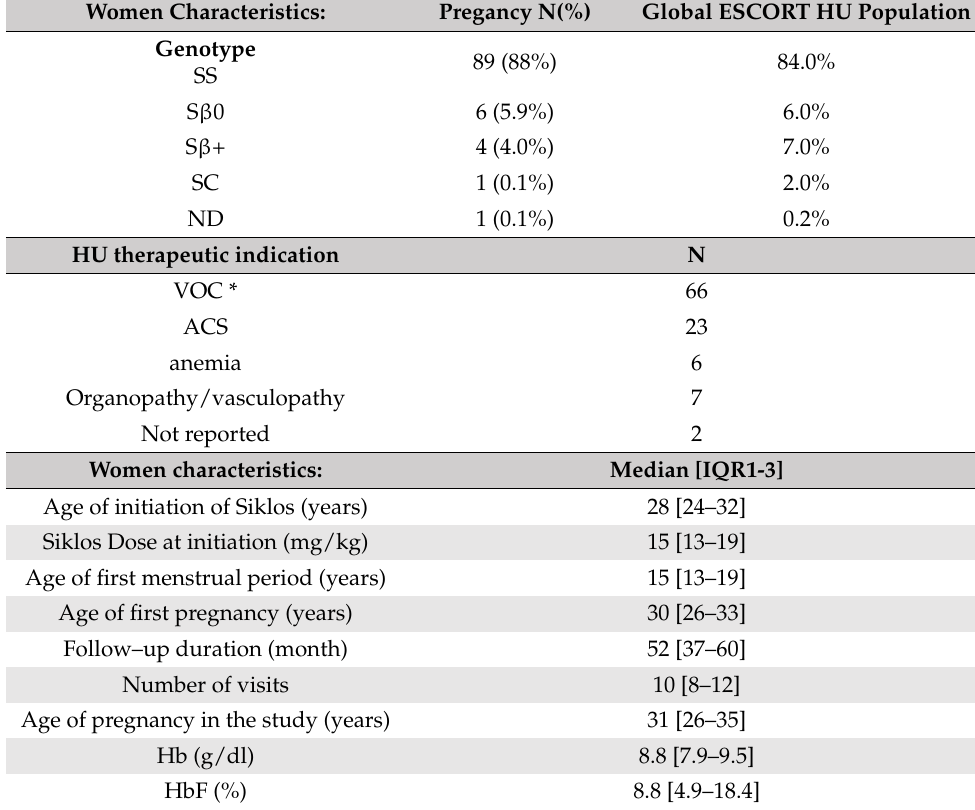
Table 2. Characteristics of pregnant women (* VOC 2.5 + 1.4/years).